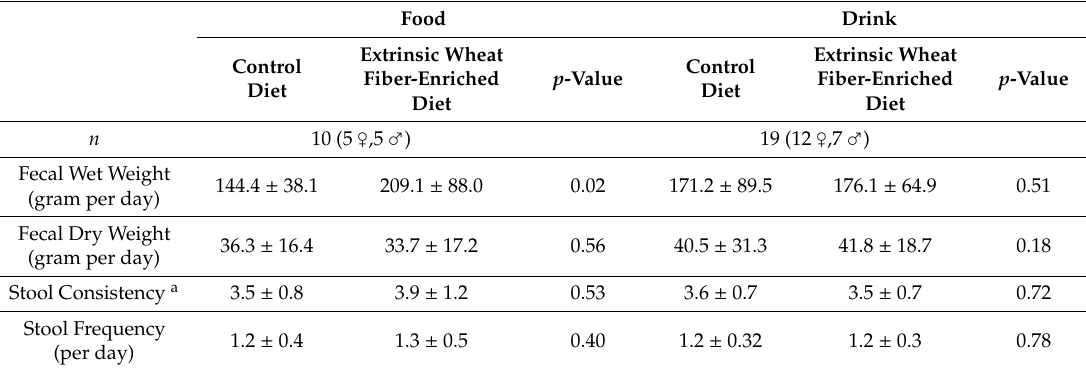
Table 1. Impact of added extrinsic wheat fiber intake on fecal bulk.